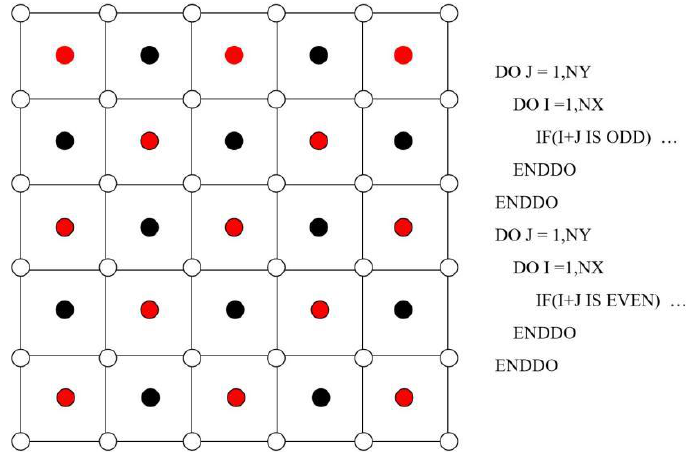
Figure 4. The Red/Black ordering and the pseudo code for its